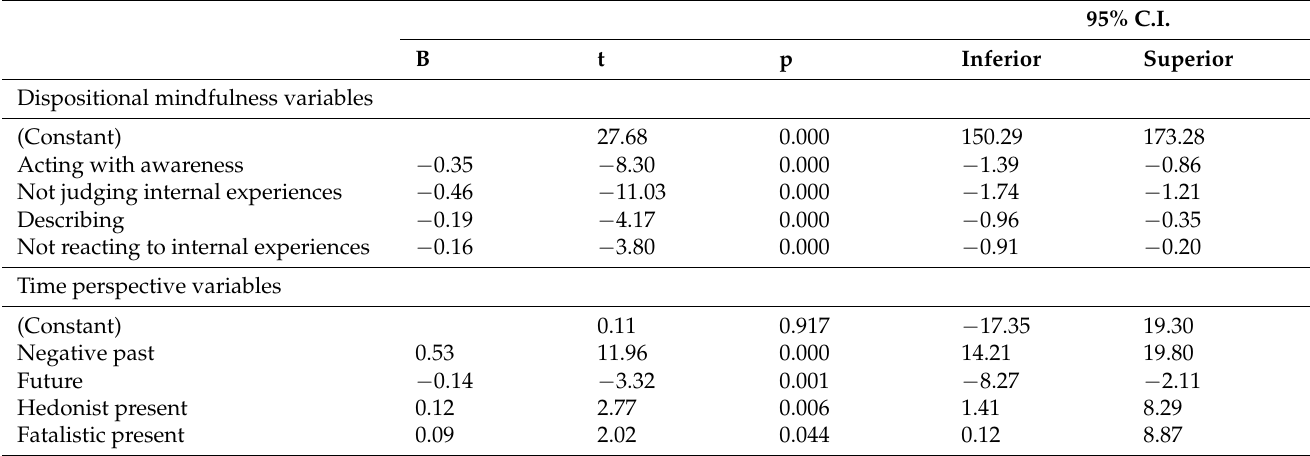
Table 1. Multiple Regression Analyses with Mindfulness and Time perspective variables (step-by-step method) in predicting general level of difficulties in emotional regulation (N = 320).